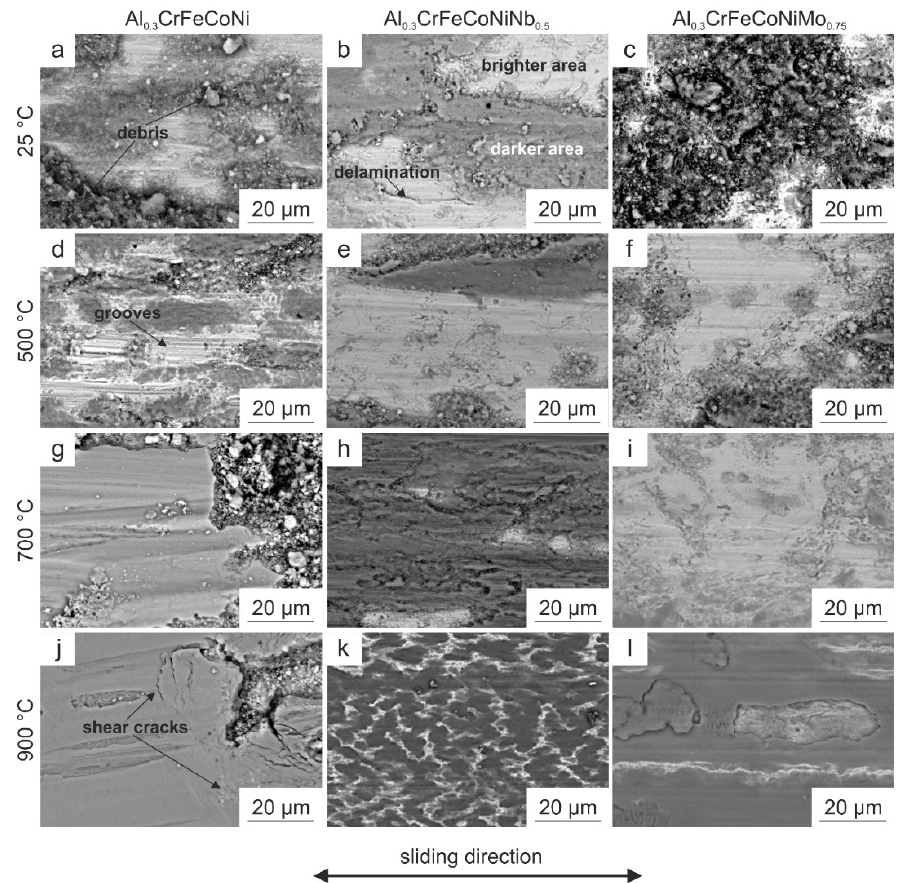
Figure 7. SEM (BSE) images of the wear tracks of HVOF-sprayed ( a , d , g , j ) Al 0.3 CrFeCoNi, ( b , e , h , k ) Al 0.3 CrFeCoNiNb 0.5 and ( c , f , i , l ) Al 0.3 CrFeCoNiMo 0.75 tested at ( a – c ) 25 °C, ( d – f ) 500 °C, ( g – i ) 700 °C, and ( j – l ) 900 °C. The wear tracks of all HVOF-sprayed coatings show brighter and darker areas ( b ). The brighter areas are characterized by grooves ( d ). In addition, debris ( a ) on all HVOF-sprayed coatings was observed after testing at 25°C and 500 °C and for Al 0.3 CrFeCoNi at all temperatures tested. Furthermore, delamination ( b ) was found for all HVOF-sprayed coatings at all temperatures tested. The darker areas appear to be smoother due to deformation processes during testing. Last but not least, shear cracks ( j ) were observed for HVOF-sprayed Al 0.3 CrFeCoNi and Al 0.3 CrFeCoNiMo 0.75 . EDS measurements of the darker areas contain more O (about 60 at.%) than the brighter areas. The oxide layers consist of the combination of the solid solution of Al 0.3 CrFeCoNi, Al 0.3 CrFeCoNiNb 0.5 and Al 0.3 CrFeCoNiMo 0.75 and O (up to 60 at.%). The proportion